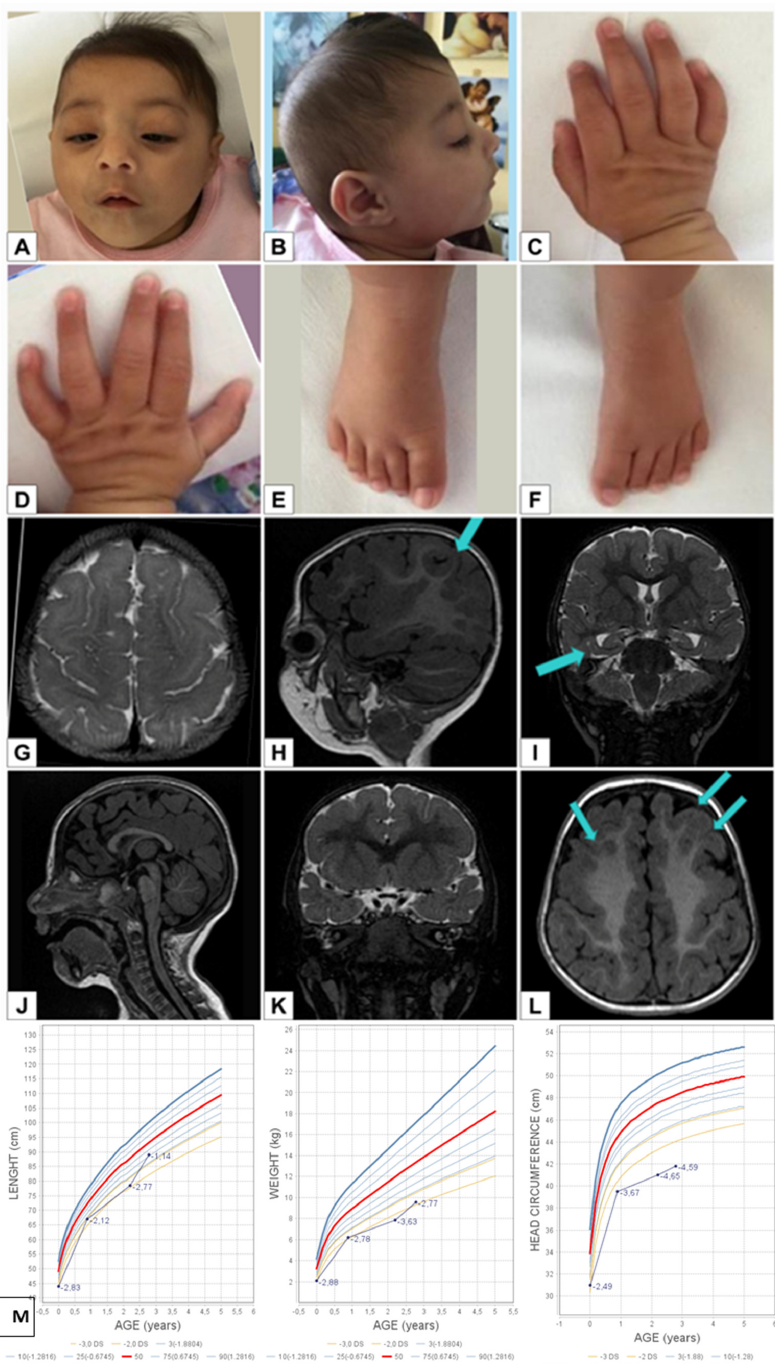
Figure 1. ( A , B ) Microcephaly, slight posterior plagiocephaly, bilateral ptosis, nystagmus, anteverted nostrils and down-turned corners of the mouth. ( C – F ) Hands: single palmar crease on the left hand, slight bilateral clinodactyly of the 5th finger. Feet: slight cutaneous syndactyly of second–third toes on the right foot. ( G – L ) Brain MRI (age 3 months): subarachnoid dilatation and abnormal gyration in the fronto-temporal regions, slight hippocampal malrotation, subcortical heterotopia, slightly thickened cerebral cortex. ( M ) Somatometric data at birth, 11 months, 2 years and 3 months, 3 years and 10 months of age. She had primary microcephaly, slight posterior plagiocephaly, bilateral ptosis, nystag- mus, anteverted nostrils and down-turned corners of the mouth (Figure